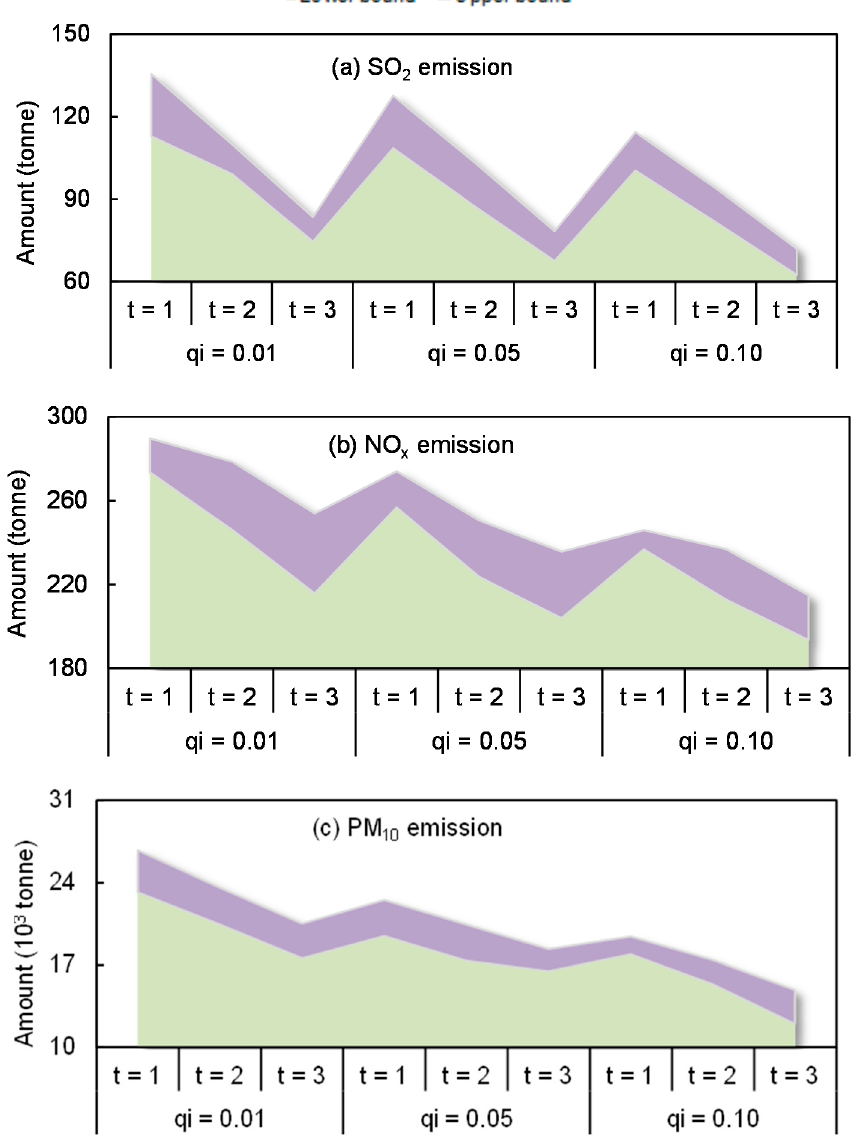
q level: ( a ) SO 2 emission; ( b ) NO x emission; ( c ) PM 10 i